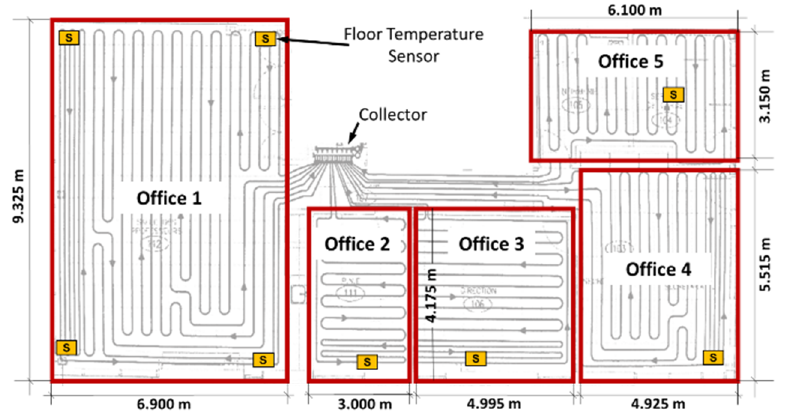
Figure 11. Plan view of the offices with hydronic radiant floor system.